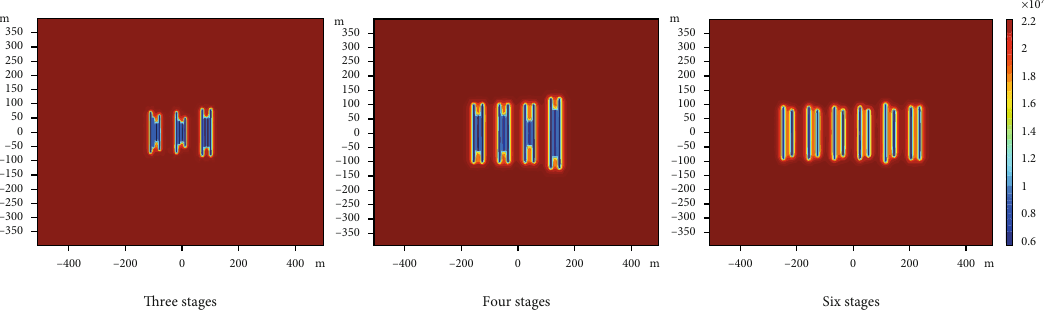
Figure 13: Pressure distribution after three months of production for multistage scenarios of three stages, four stages, and six